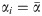
Activation parameters and H in MWC.(a) Scatter plot for H when ci are independently and logarithmically chosen from the interval [10−4, 0.9] (dots) and when ci are all identical (solid line), L = 1000, and αi=α¯ for n = 2, 3, 4, 6, 8. (b) Scatter plot for H for increasing total conformational free energy contribution (Eq 3) when ci = c ∈ [10−4, 0.9], αi=α¯, and L = 1000 for n = 2, 3, 4, 6, 8. Asterisk is the approximated H for Ste5 from [24]. (c) Scatter plot for H for increasing total conformational free energy contribution (Eq 3) when ci=c¯∈[10-4,0.9], αi=α¯, and L = 1000 for n = 2, 3, 4, 6, 8. Diamonds represent the knee of the curve. (d) H for increasing total conformational free energy contribution where ci=c¯∈[10-4,0.9], αi=α¯ and L = 1000 and with a maintenance cost of 4 kcal/mol per site where n = 2, 3, 4, 6, 8. The Ste5 data point is added for illustration purposes with the same maintenance cost for each of the 8 phosphorylation sites.